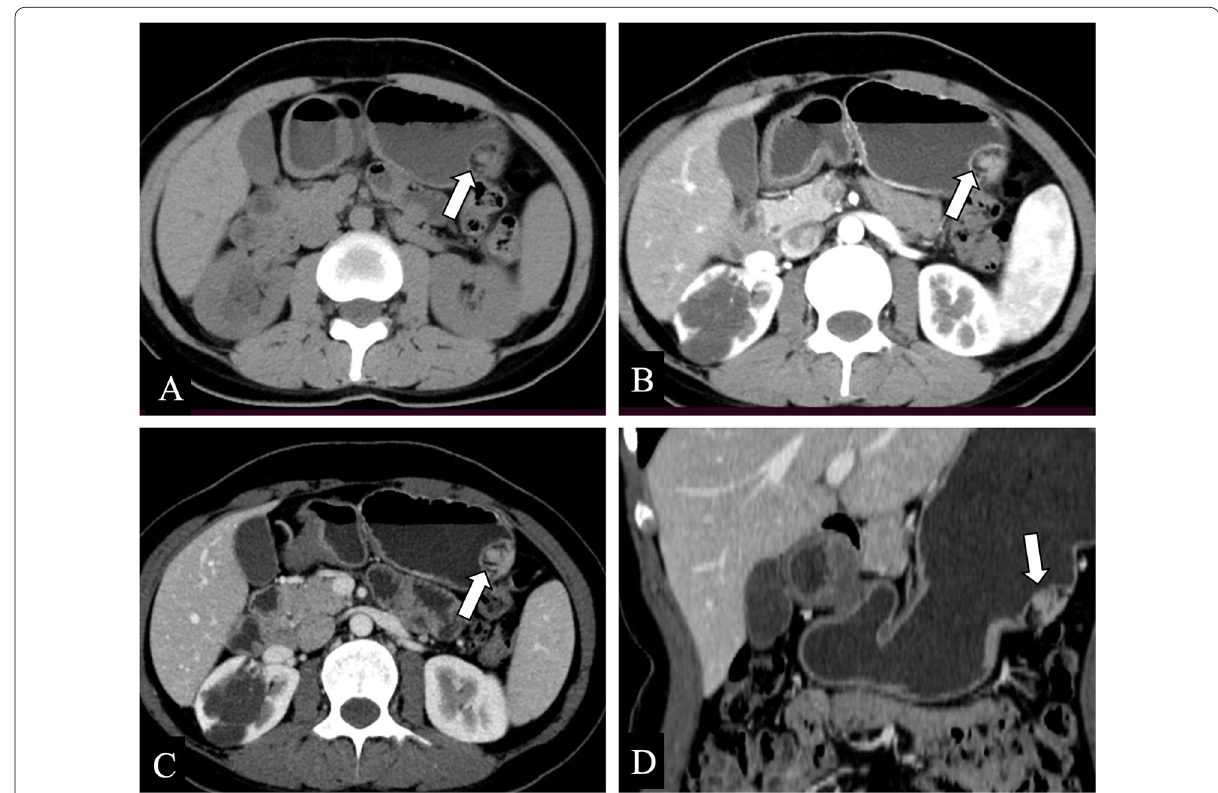
Fig. 1 a – d Axial plain/arterial/venous phases CT images of a 33‑year‑old female showed a 2.3 lesion (white arrows), indicating an endoluminal growth pattern of a heterotopic pancreas in the gastric body ( a – c ). d Coronal venous phase CT